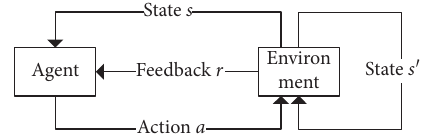
Figure 1: The basic reinforcement learning